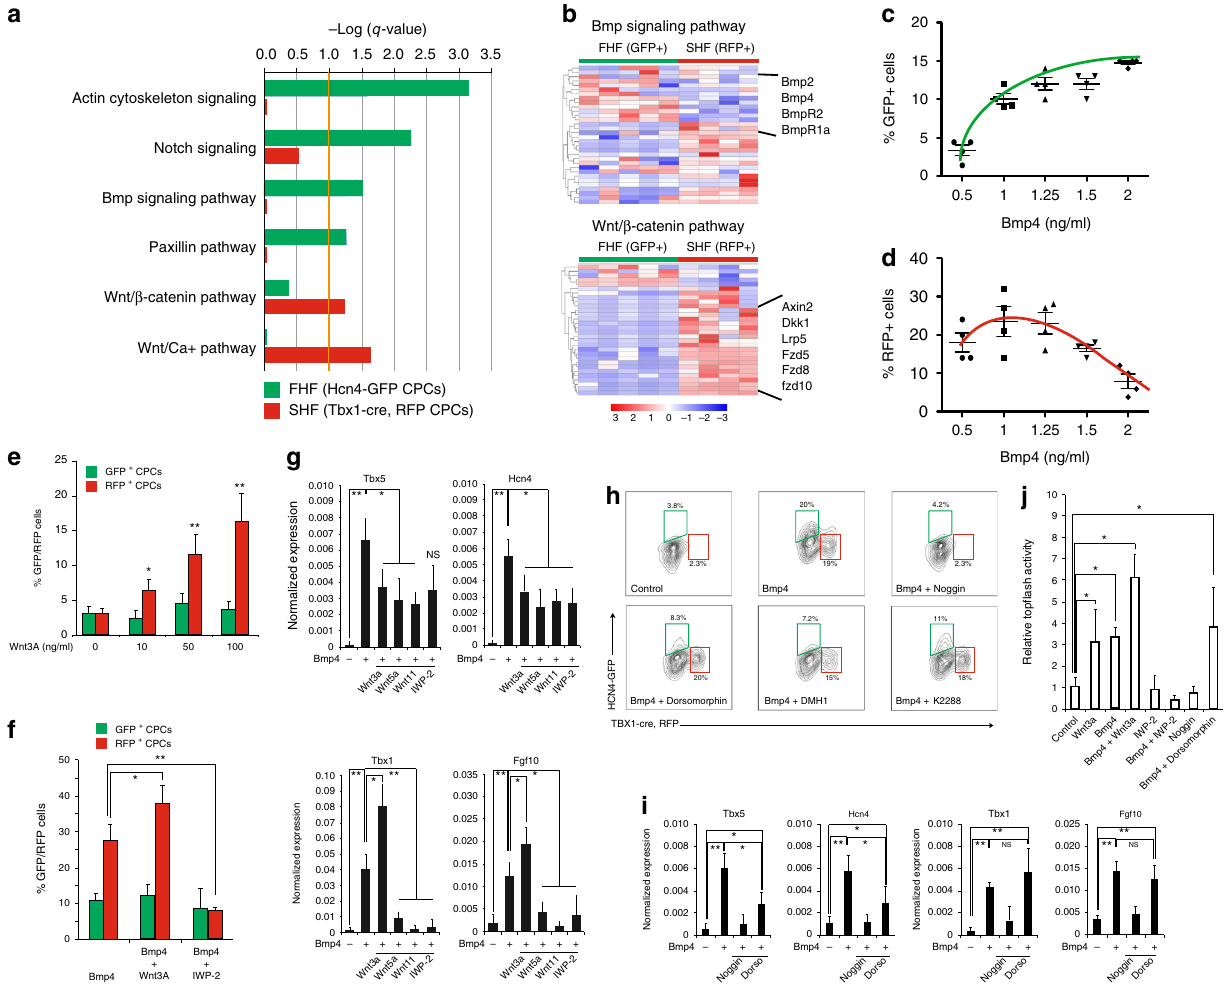
Fig. 3 Bmp and Wnt activities regulate heart fi eld speci fi cation in cardiac spheroids. a Ingenuity pathway analysis of genes differentially expressed in Hcn4- GFP + and Tbx1-Cre, RFP + CPCs in vivo. We focused our analysis on pathways involved with “ organism growth and development ” . Data are shown as logarithm of Benjamini – Hochberg adjusted p-value, with threshold for signi fi cance of p -value < 0.1. b RNA-seq heatmaps of selected differentially regulated genes (Benjamini – Hochberg adjusted p -value < 0.1) from Bmp signaling pathway and Wnt/ β -catenin pathways. Data are shown as row-scaled regularized logarithmic transformation of counts as produced by the DESeq2 package. c Vertical scatter plot showing the effect of increasing Bmp4 on formation of Hcn4-GFP + CPCs (green trend line). d Vertical scatter plot showing the effect of increasing Bmp4 on formation of Tbx1, RFP + CPCs (red trend line). Both analyses ( c , d ) were performed on GFP + /RFP + percentages from fl ow cytometric analyses in Fig. 1d. e Number of Hcn4-GFP + CPCs and Tbx1-Cre, RFP + CPCs after induction with increasing concentrations of Wnt3A. f Number of Hcn4-GFP + CPCs and Tbx1-cre, RFP + CPCs after induction with Bmp4 (1.25 ng/mL) in combination with Wnt3A. g qPCR analyses of Tbx5, Hcn4, Tbx1, and Fgf10 after induction with Bmp4 (1.25 ng/mL) alone or in combination with Wnt3a (100 ng/mL), Wnt5A (100 ng/mL), Wnt11 (100 ng/mL), and IWP-2 (0.5 μ M). h Representative FACS plots of Hcn4-GFP + and Tbx1-cre, RFP + CPCs at day 5.5. i qPCR analyses of Tbx5, Hcn4, Tbx1, and Fgf10 after induction with Bmp4 (1.25 ng/mL) alone or in combination with Noggin (100 ng/mL) or dorsomorphin (100 nM), K2288 (100 nM), and DMH1 (100 nM). j Top fl ash assay after induction (88h of differentiation) with Bmp4 (1.25 ng/mL) or Wnt3A (100 ng/mL) alone or in combination with Wnt3a, IWP-2, Noggin or Dorsomorphin. All data are mean ± SEM; n = 3; * p <